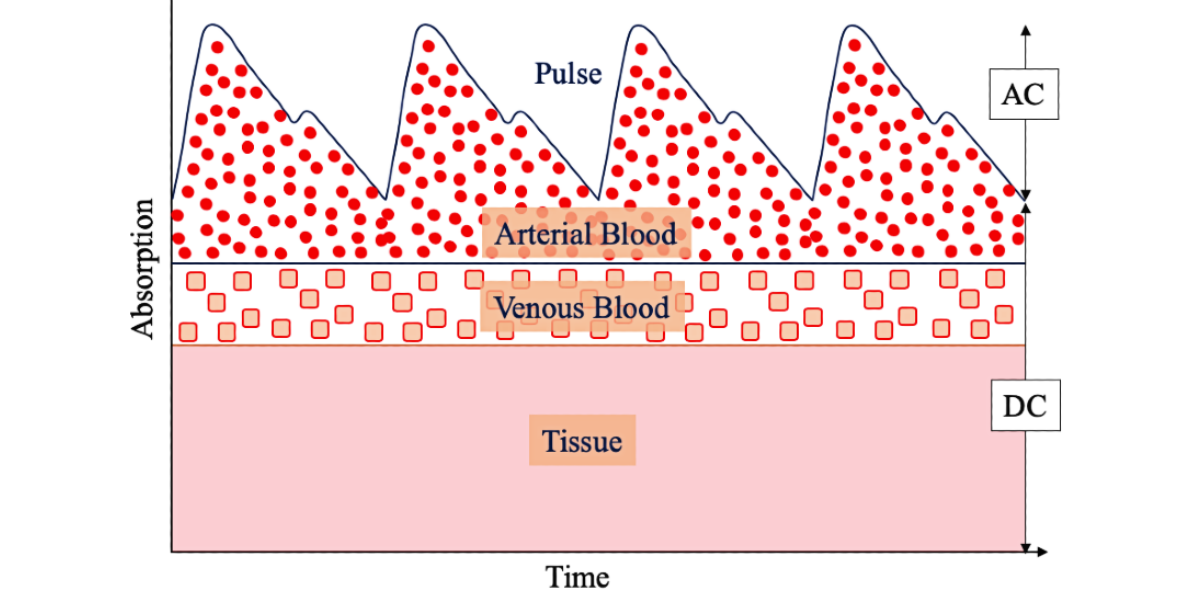
The absorption of light by melanin and fat in the skin exhibits a significant response in the shorter wavelengths of light